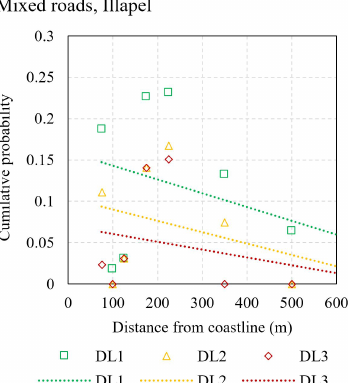
Figure 16. Linear best-fit probability of reaching or exceeding a given damage level, by distance from coastline (as a proxy for in- undation energy), for the 2015 Illapel tsunami, Coquimbo, Chile.